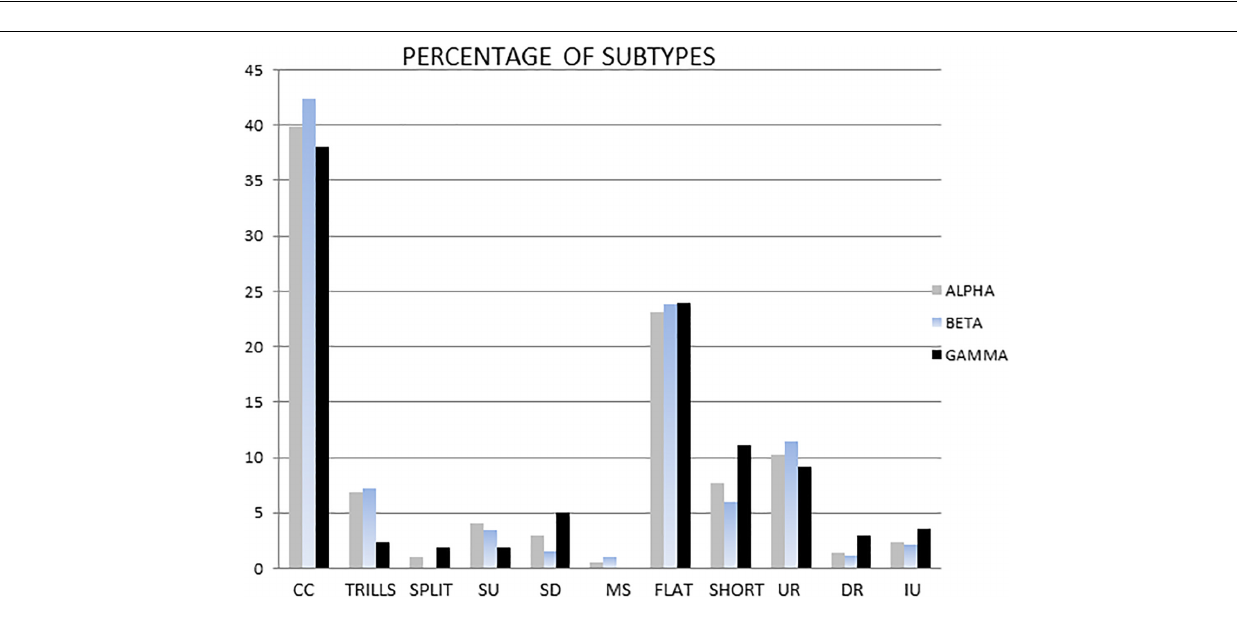
FIGURE 5 | The dominant means percentage of different subtypes in the alpha, beta and gamma groups. Subtypes are shown from left to right as: complex and composite (CC), trill, flat-trill and trill with jumps (Trills), split, step up (SU), step down (SD), multi-step (MS), flat, short, upward ramp (UR), downward ramp (DR), and inverted U